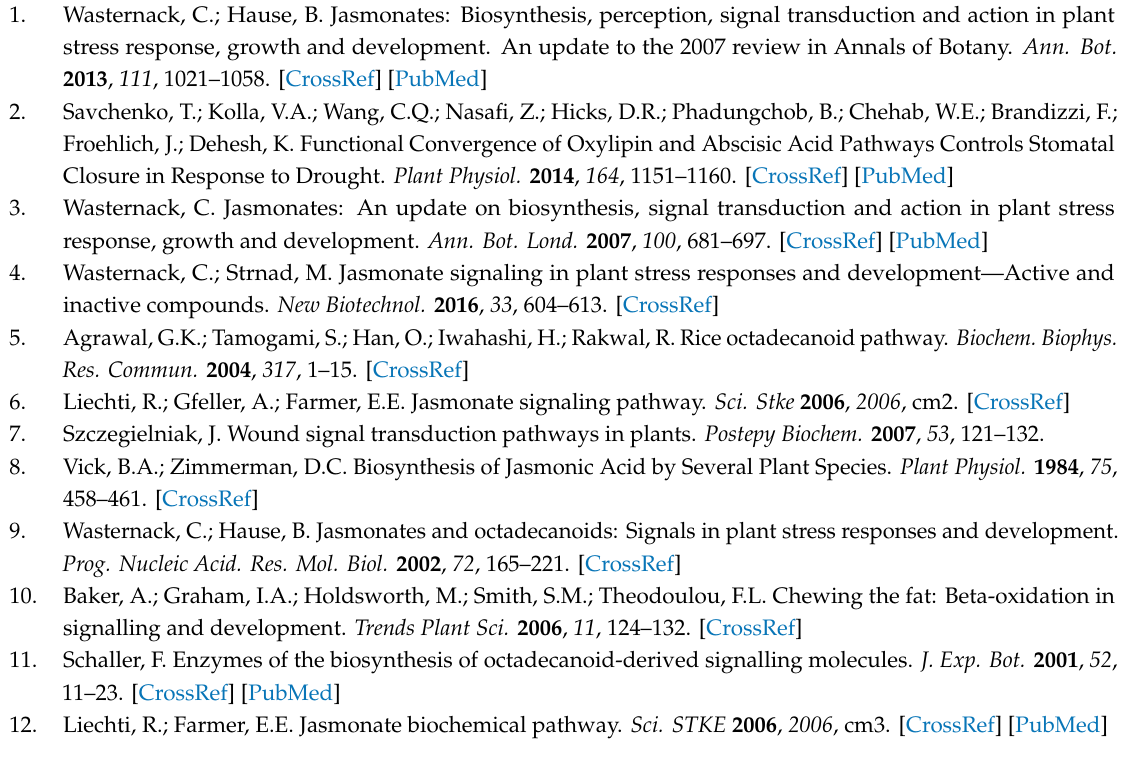
Figure S1. Chromosomal localization of GhOPR and GbOPR genes. The 10 GhOPR members were distributed into five chromosomes in G. hirsutum . Nine GbOPR members were mapped on the five chromosomes in G. barbadense ; Figure S2. GhOPR9 positively regulates cotton resistance against V. dahliae in susceptible G. hirsutum cv. Jimian No.11. (a) Disease symptoms of the TRV: 00 and TRV: GhOPR9 plants after Vd080 inoculation. Photographs were taken at 21 days after inoculation. (b) The expression level of GhOPR9 in the TRV: 00 and TRV: GhOPR9 plants. Total RNA was isolated from the TRV: 00 and TRV: GhOPR9 plants roots after the TRV: GhPDS lines presented a photobleaching phenotype. GhUB7 was used as the reference. Each experiment was performed using three replicates. (c) Disease index of the TRV: 00 and TRV: GhOPR9 plants at 12 days, 18 days, and 21 days after inoculation with Vd080. Each experiment was performed using three replicates. (d) qPCR analysis of the relative fungal biomass in stems of the TRV: 00 and TRV: GhOPR9 plants at 21 days after Vd080 inoculation. Each experiment was performed using three replicates. Di ff erences between groups were compared using the t -test (* p < 0.05, ** p < 0.01, *** p < 0.001); Figure S3. The expression level of GhOPR8 in the TRV: 00 and TRV: GhOPR9 plants. Total RNA was isolated from the TRV: 00 and TRV: GhOPR9 plants roots after the TRV: GhPDS lines presented a photobleaching phenotype. GhUB7 was used as the reference. Each experiment was performed using three replicates; Table S1. Primers used in this research work; Table S2. Details of the cotton OPR proteins physiochemical properties and gene annotation; Table S3. The named of di ff erent species OPR proteins; Table S4. The amino acid sequences of 15 conserved motifs; Table S5. Information of the homologous genes and the gene type of OPR genes in G. hirsutum and G. barbadense ; Table S6. Details of cis-regulatory elements found in the 1.5 kb promoter region of the GhOPR